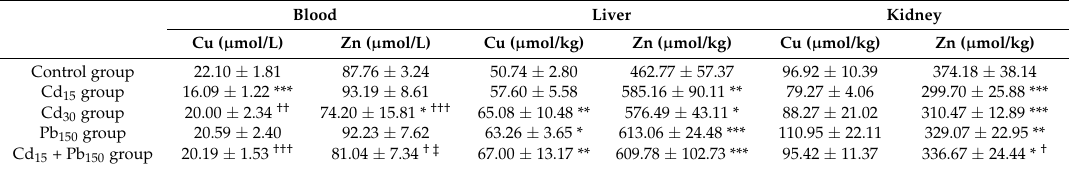
Table 5. Levels of Cu and Zn in rat blood, liver, and kidney after acute exposure to Cd or/and Pb.